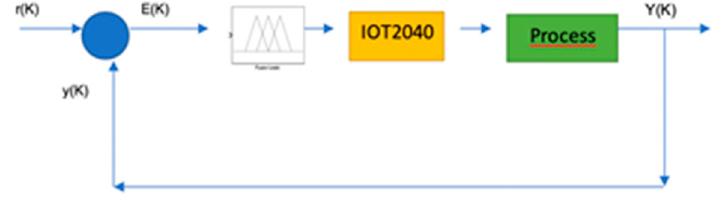
Figure A2. Fuzzy control structure.